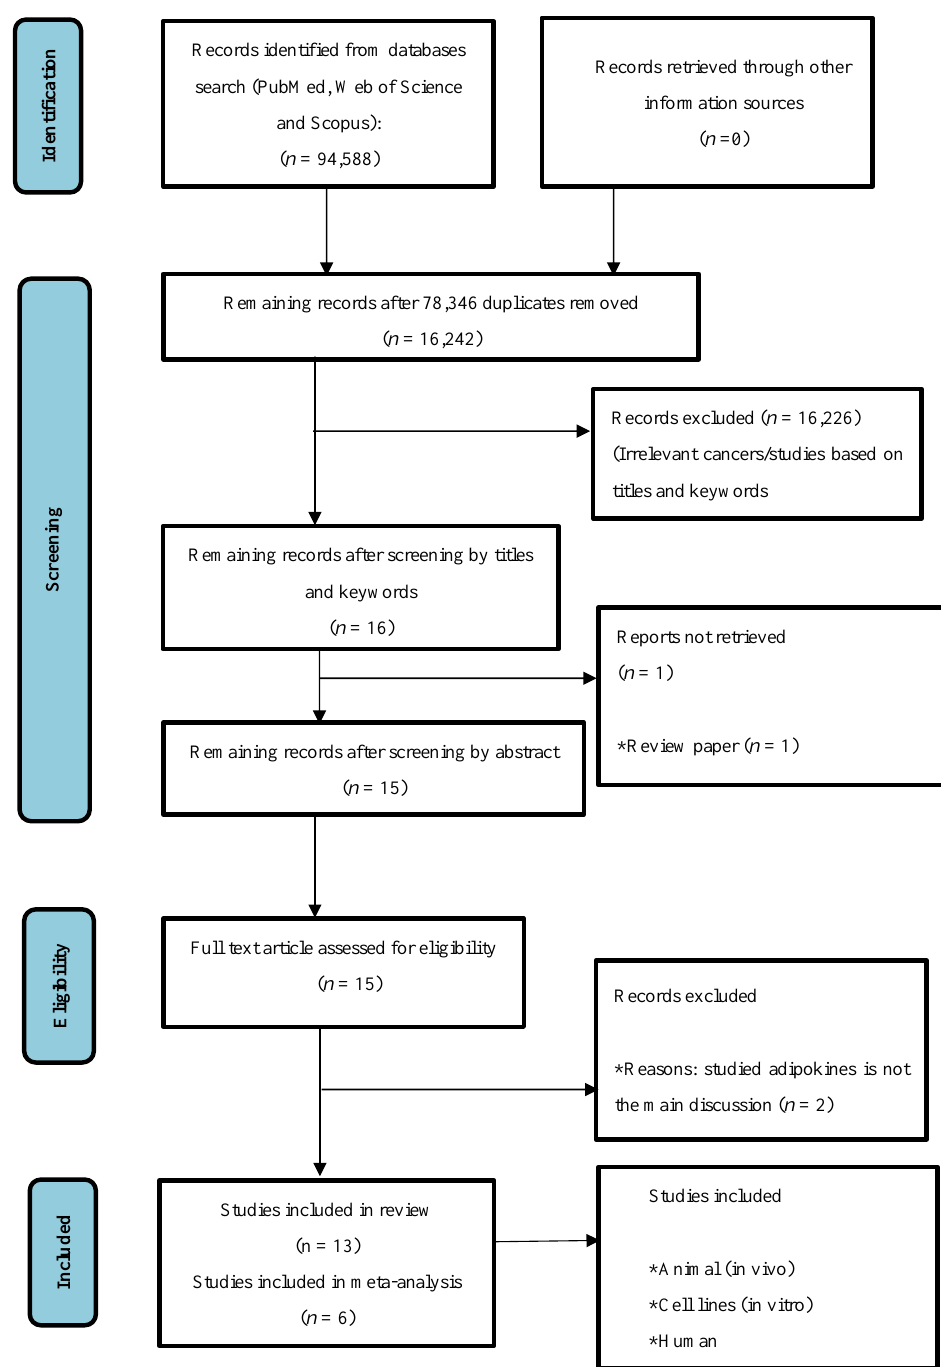
Figure 1. The PRISMA diagram. PRISMA diagram shows the selection process of the studies included in the meta-analysis. * shows reasons that studies were included or